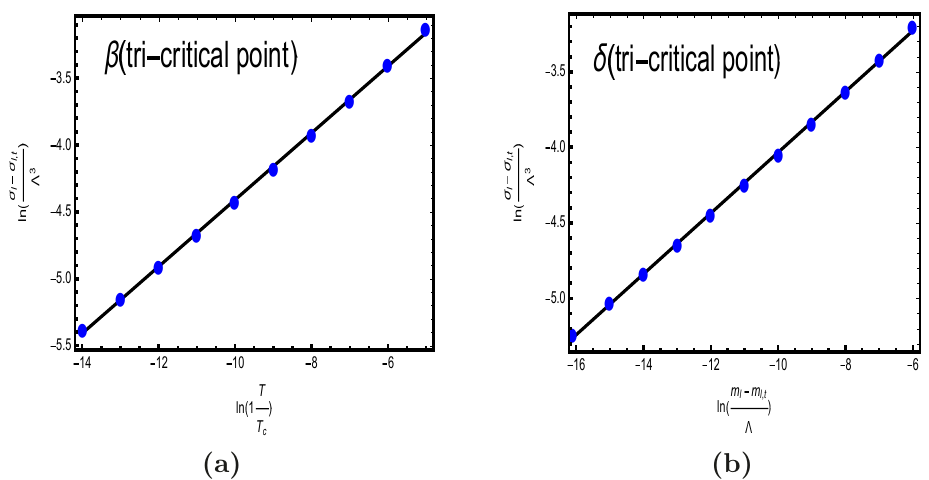
Figure 11 . Temperature and quark mass dependence of chiral condensate near the tri-critical point T l,t = 0 . 2053135 . . . GeV , m l,t = 0 , m s,t = 0 . 290 . . . GeV , σ l , c = 0 , σ s , t = 0 . 010 GeV 3 . Panel.(a) T gives ln( σ l − σ l,t ) as a function of ln(1 ), with fixed quark mass m l = m l,t = 0 , m s = m s,t = Λ 3 T c − 0 . 290 . . . GeV. Λ is taken as 1 GeV. The blue dots are model calculation and the black solid straight line are linear fitting of the dots, which has the form y = 1 . 912+0 . 250 x . Panel.(b) gives ln( σ l − σ l,t − ). The blue dots are model calculation and the black solid straight line as a function of ln( m l − m l,t Λ are linear fitting of the dots, which has the form y = 2 . 022 + 0 . 201 x −